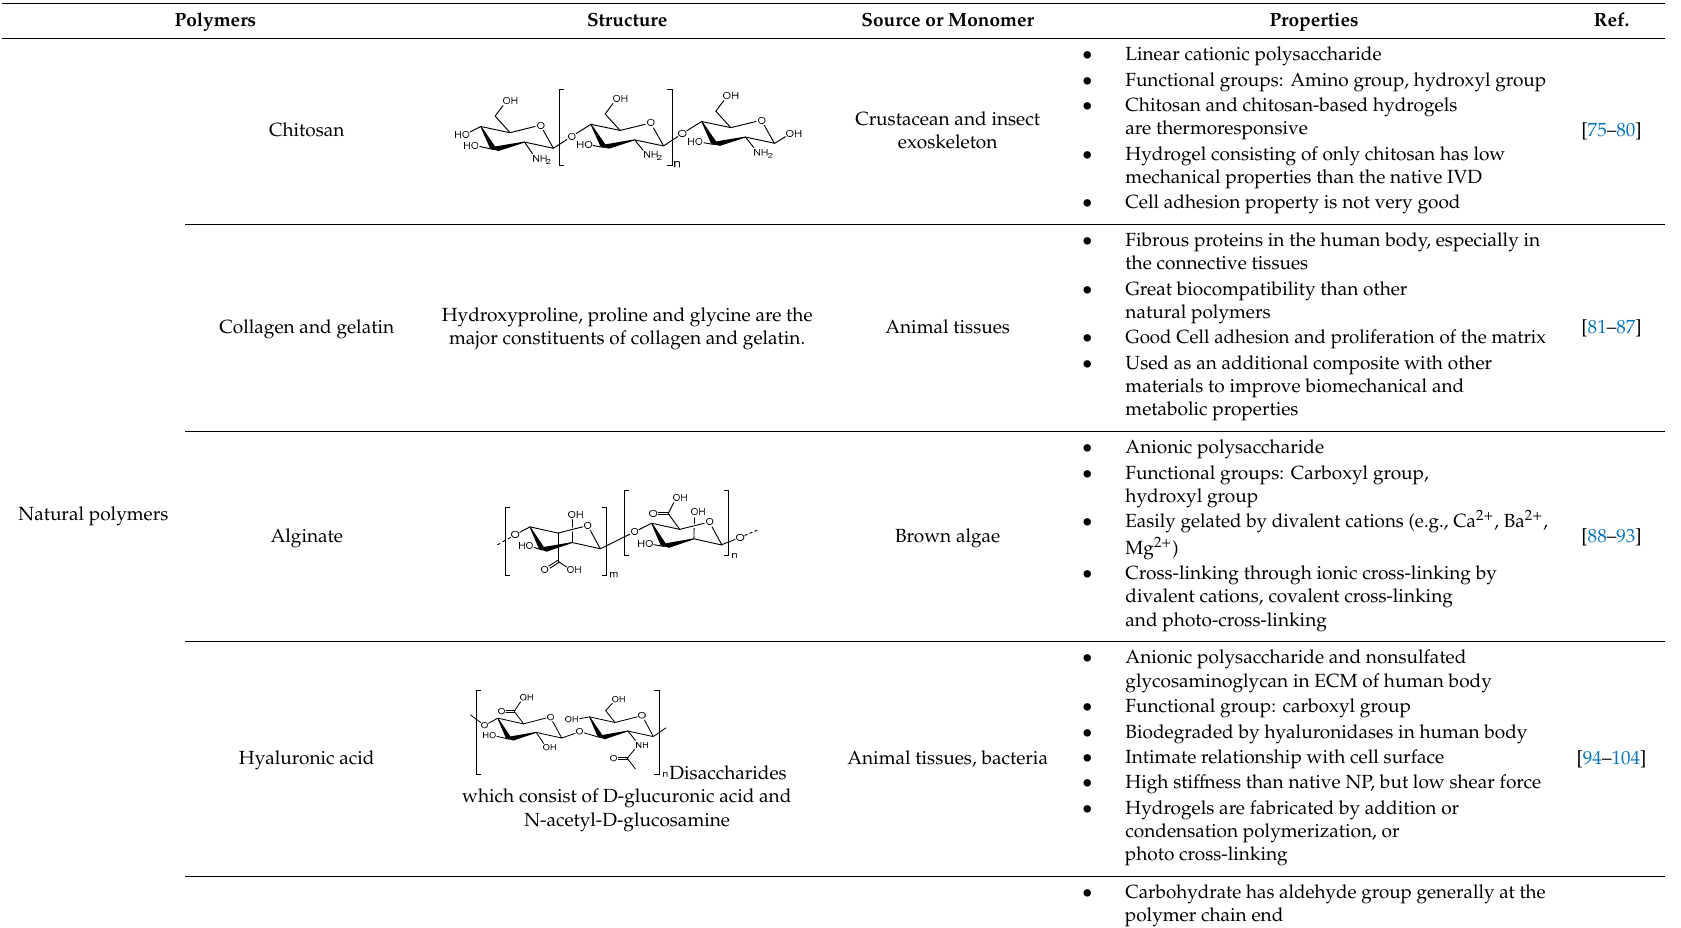
Table 1. Summary and properties of polymers for IVD regeneration.